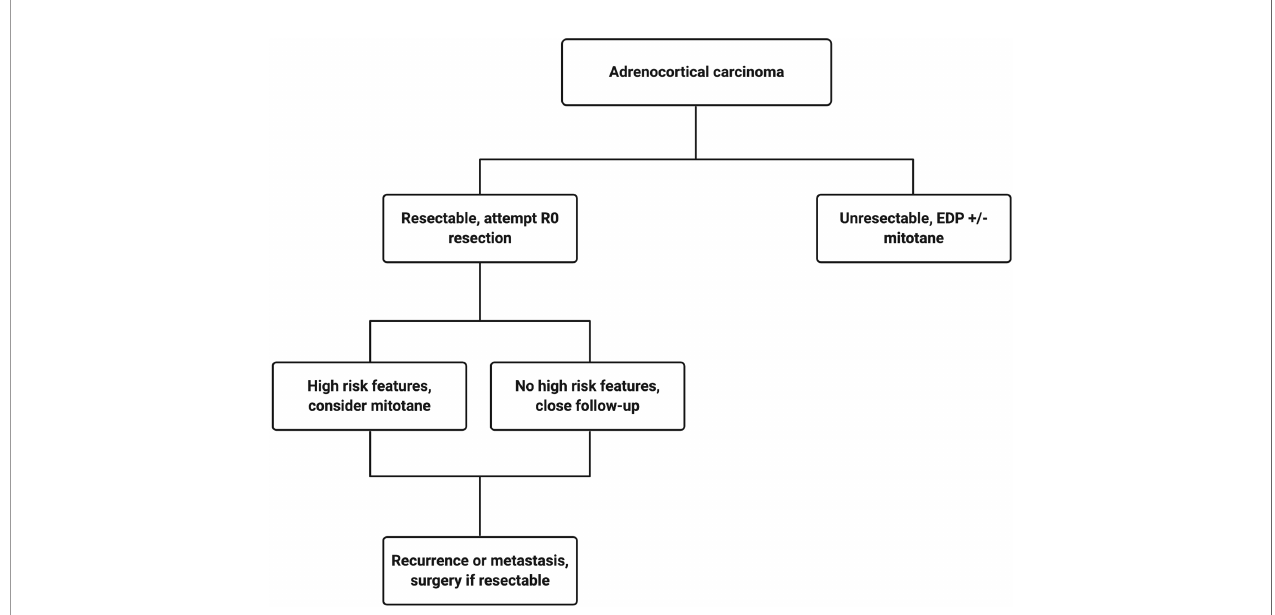
FIGURE 1 | Treatment algorithm for a patient with con fi rmed adrenocortical carcinoma. Created with